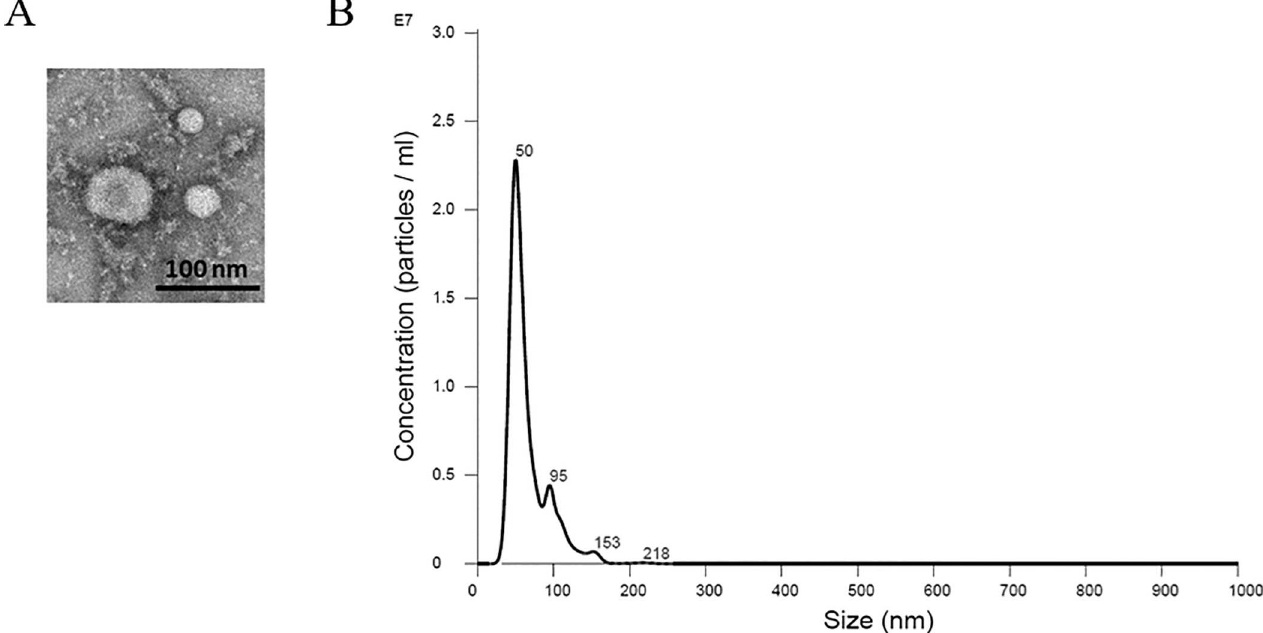
Fig 1. Size characterization of intact exosomes isolated from the apical side of LLC-PK1 cells. (A) Electron micrographof exosomes purified from LLC-PK1 cells. Negative staining transmission electron microscopy shows a field of exosomes rangingfrom 30–100nm in size. Bar, 100nm. (B) Confirmation of exosomes size distribution and concentration by NanoSight analysis. Samples were preparedto a 1:1000 dilution in 1X phosphatebuffered saline before being loadedonto a NanoSightNS300 with a high sensitivity camera and green 532nm laser. The size distribution profiles for the purified exosomes showed a peak at 50 nm. The concentration of the exosomes with a diameter of 50 nm in size was